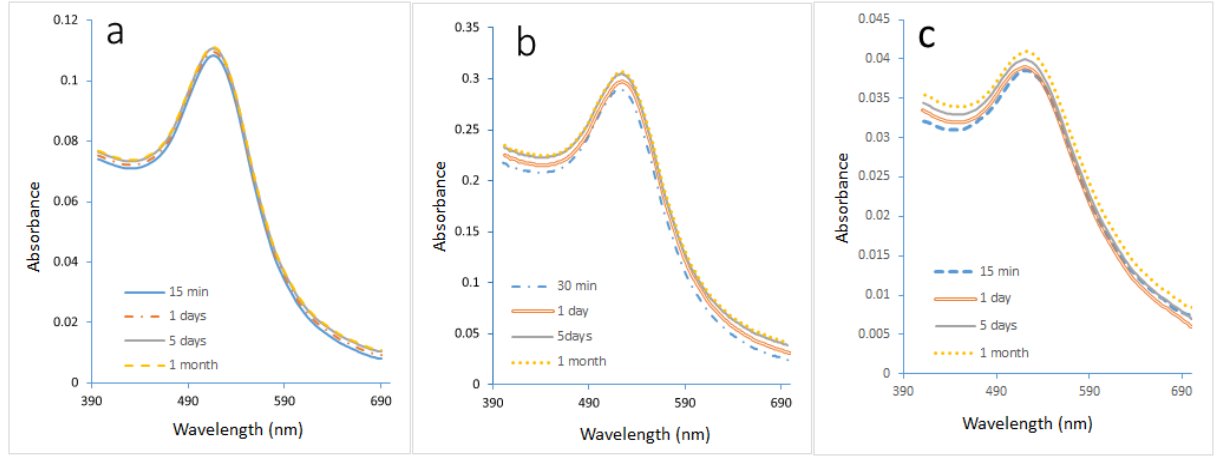
Figure 1. The UV-spectra of GNP samples prepared under optimal conditions in Microreactor mode. ( a ) in the presence of PVA stabilizer. ( b ) in the absence of the stabilizer. ( c ) In the absence of stabilizer and using the batch method.